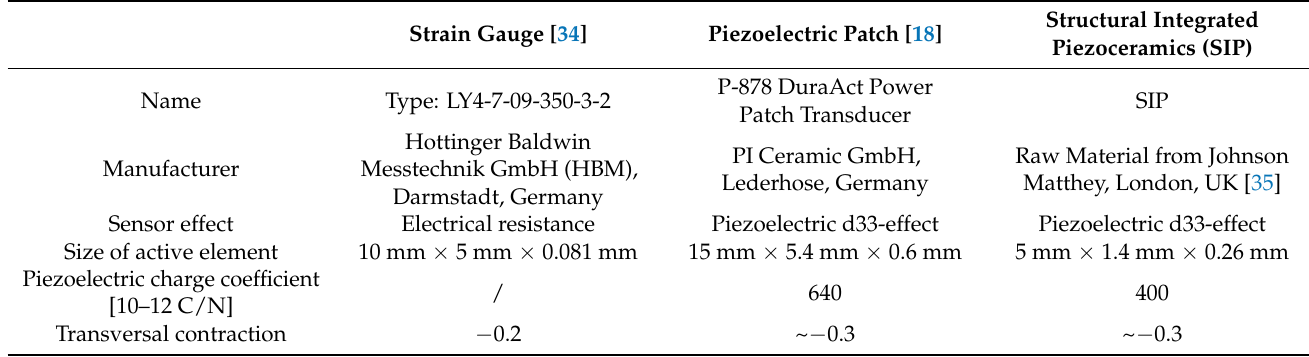
Table 1. Overview of used sensor